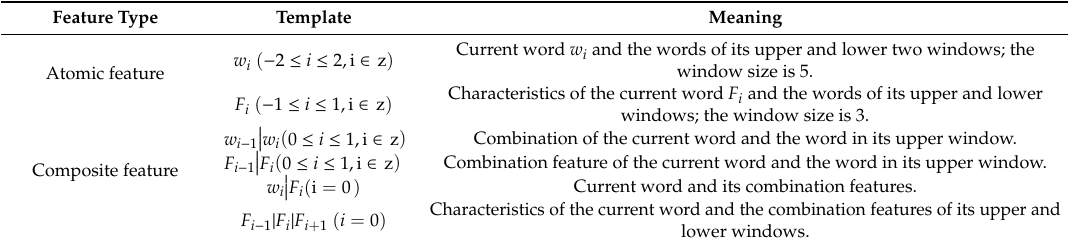
Table 3. The definitions of feature